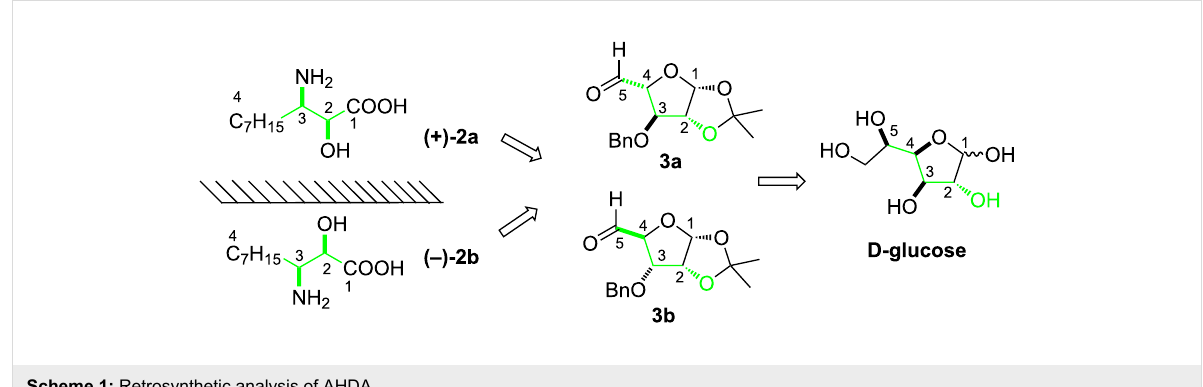
Scheme 1: Retrosynthetic analysis of